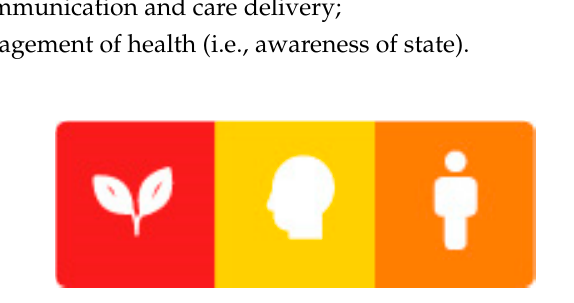
Figure 4. Wellness indicator.